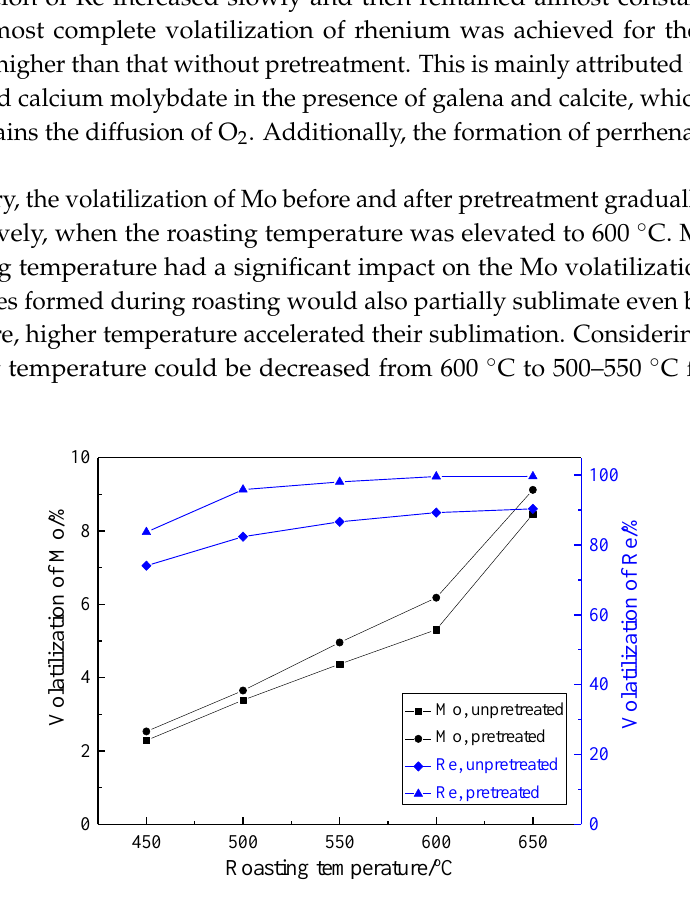
Figure 7. Effect of roasting temperature on the volatilization of Mo and Re.